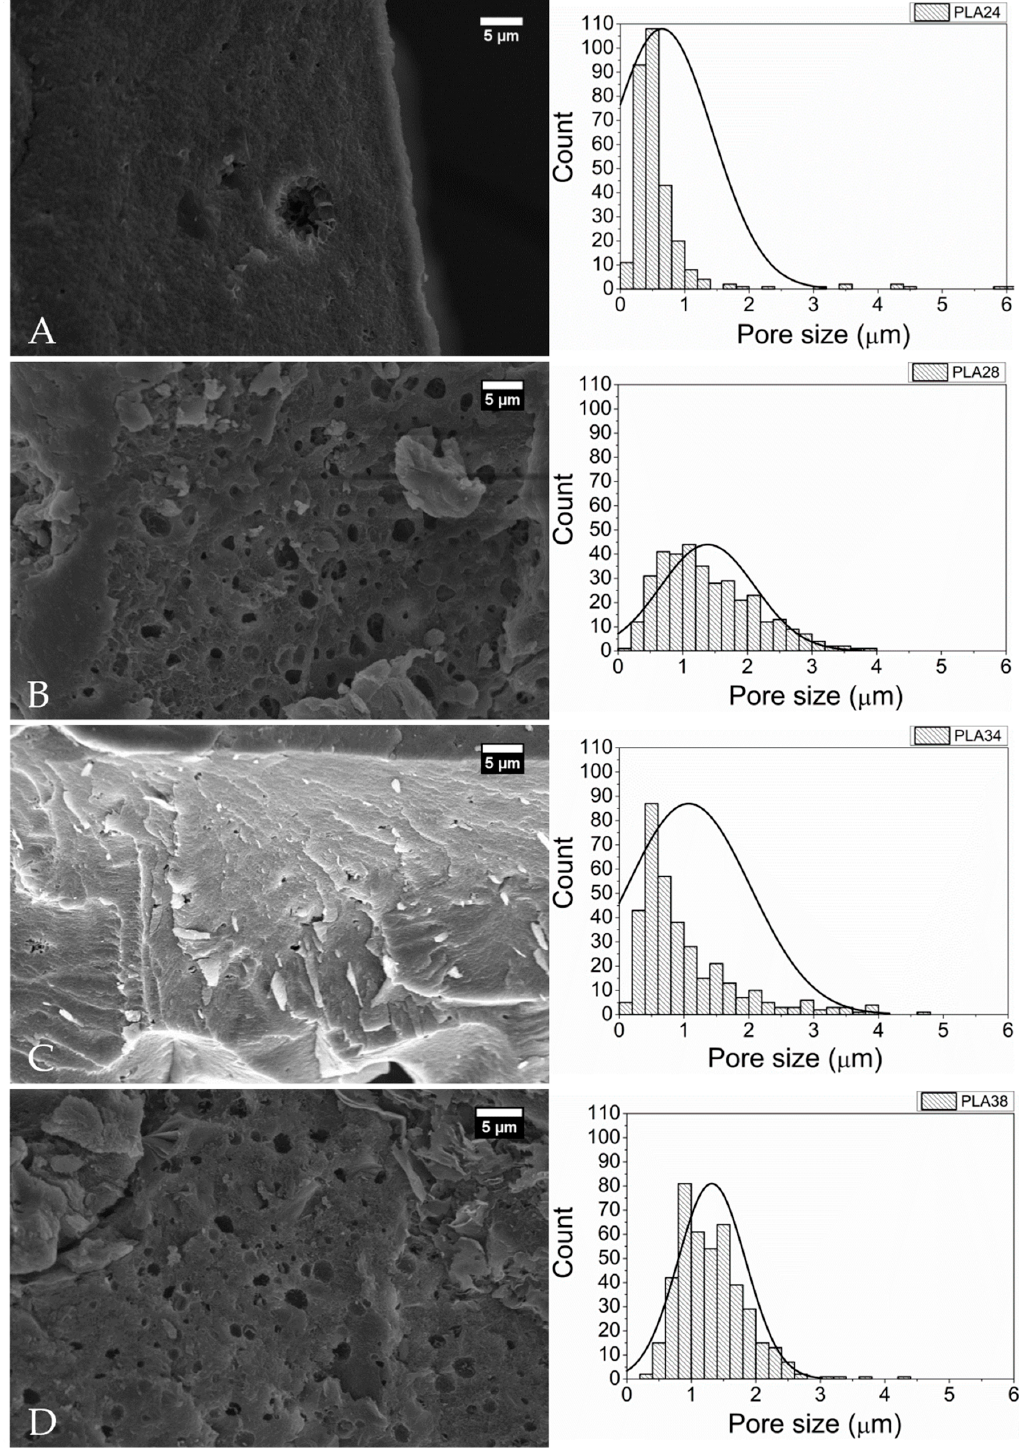
Figure 6. SEM micrographs and pore size distribution histograms of the surface of PLA implanted subcutaneously in one horse. ( A ) Twenty-fourweeks following implantation; ( B ) 28 weeks following implantation; ( C ) 34 weeks following implantation; and ( D ) 38 weeks following implantation.